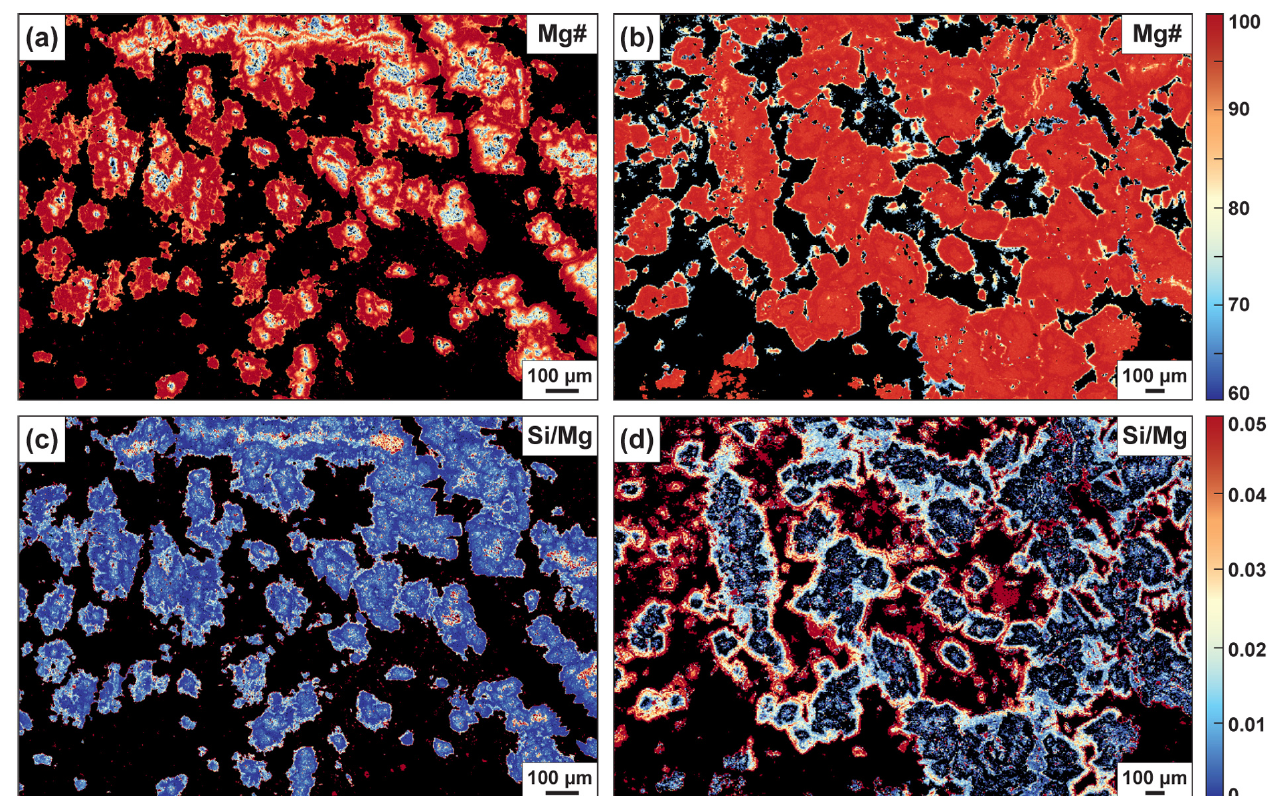
Figure 5. Quantitative Mg# and Si / Mg distribution maps of Fe-core ( a and c , 50Z-01-75-80) and Mg-core spheroids ( b and d , 46Z-4-46-51) in listvenites presented in Fig.